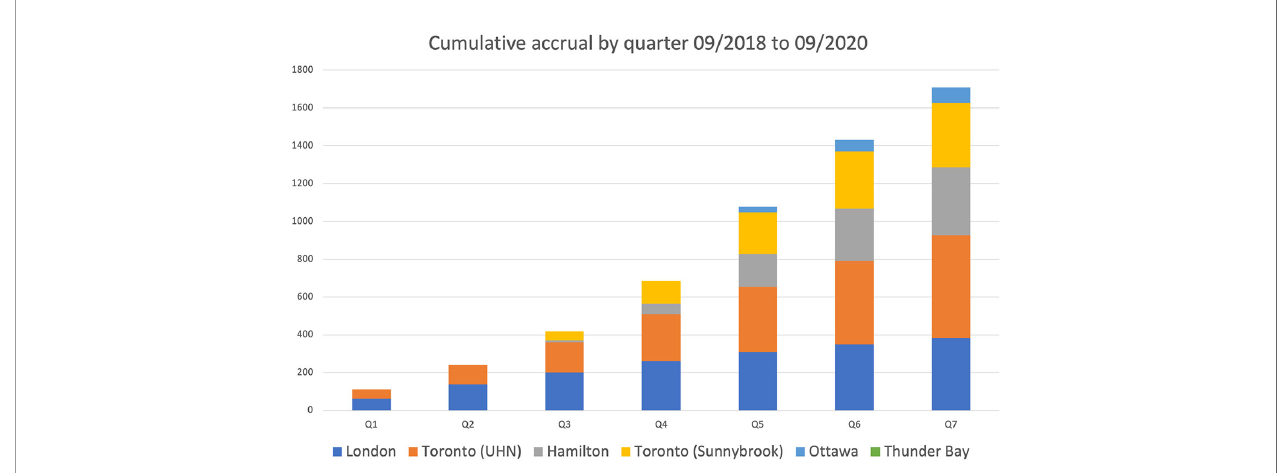
FIGURE 1 | Location of participating PREP Centers.